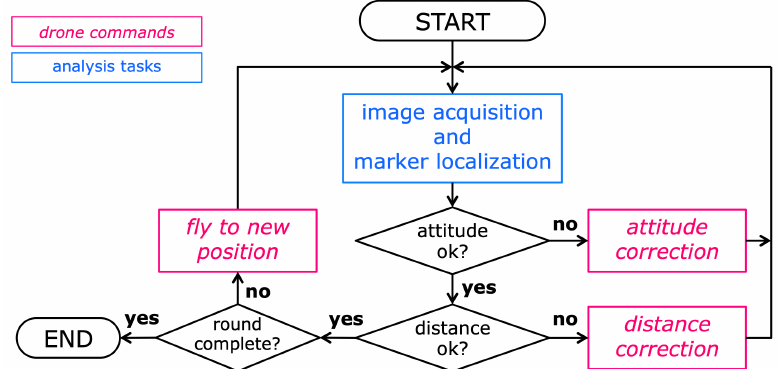
Figure 2. High-level flow diagram of the mission control algorithm. The blue block corresponds to image analysis tasks computed by the application in real time; the red blocks correspond to flight commands issued by the application to the drone.